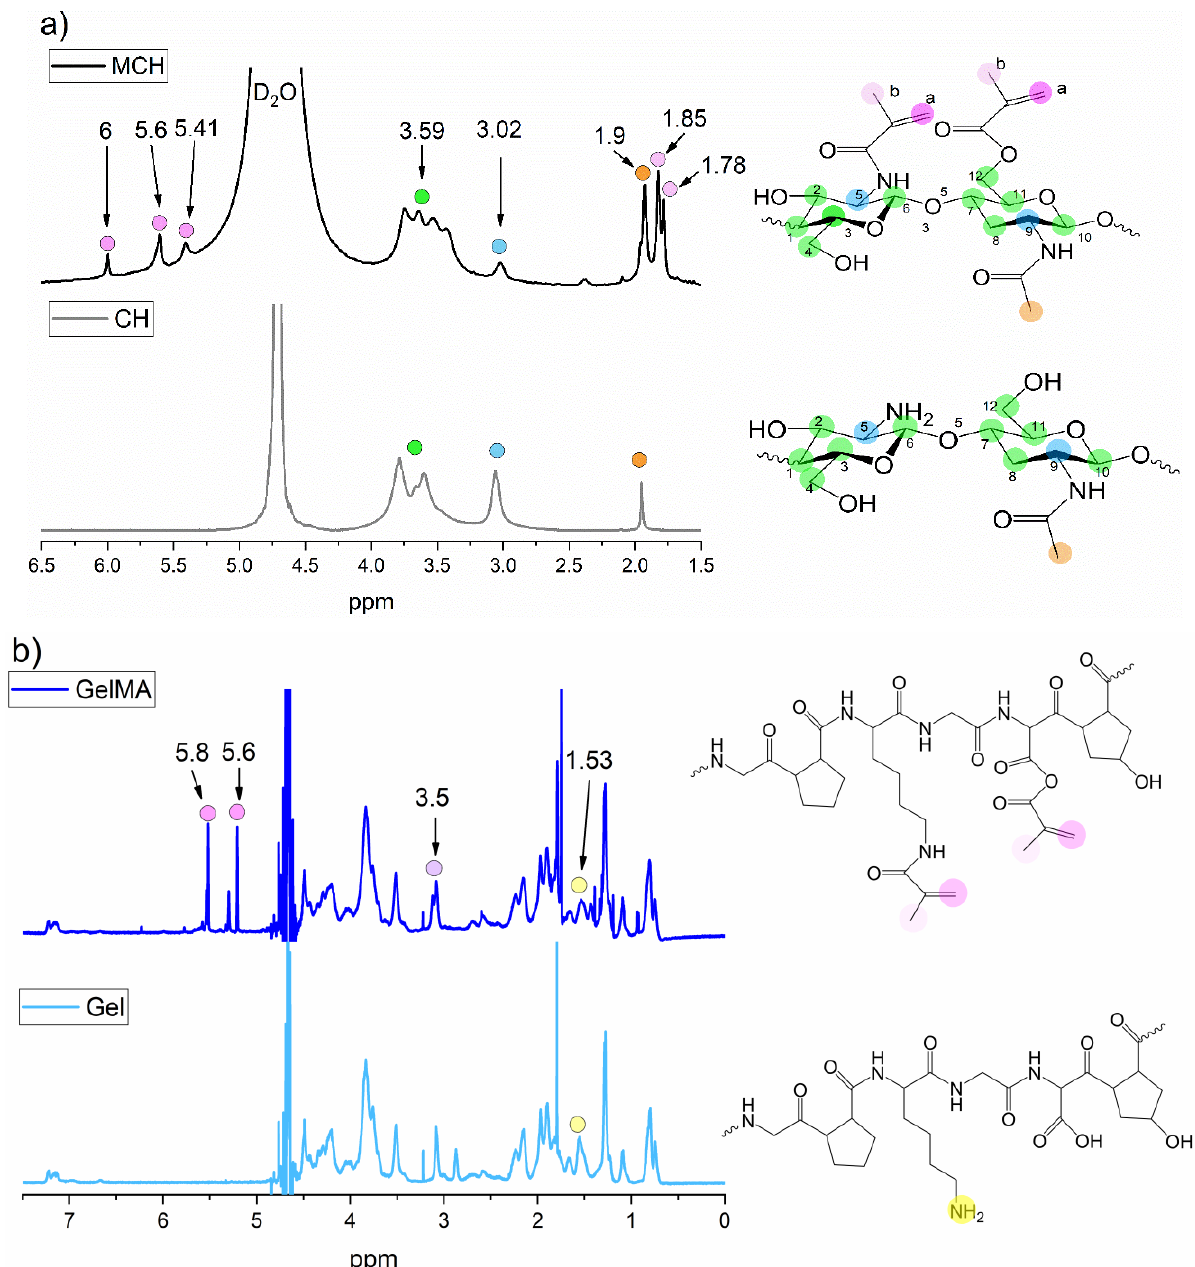
Figure 1. Scheme of the methacrylation reaction of ( a ) chitosan and ( b ) gelatin. The CH and Gel methacrylation reactions were investigated and confirmed by 1 H- NMR and FTIR. Figure 2a shows a comparison between the CH and MCH 1 H-NMR spec- tra. The CH spectrum displays the typical CH peaks: the quadruplet peak at δ = 3.59 ppm represents the protons in 1 – 4, 6 – 10, 12 positions while the peak at 3.02 ppm represents the protons in 5, 11 positions of the chitosan ring. The peak at δ = 1.9 ppm represents the ( N - acetyl) D -glucosamine group [48,49]. In the MCH spectrum, new peaks can be seen at δ = 6, 5.60 and 5.41 ppm representing the =CH 2 of the methacrylic double bonds and at δ = 1.85 and 1.78 ppm corresponding to the − CH 3 methyl groups of the grafted methacrylated moieties. As can be observed, there are two types of − CH 3 signals and three different peaks corresponding to the =CH 2 protons, meaning that the methacrylated groups are bonded to both the − NH 2 and the − OH groups of the chitosan.